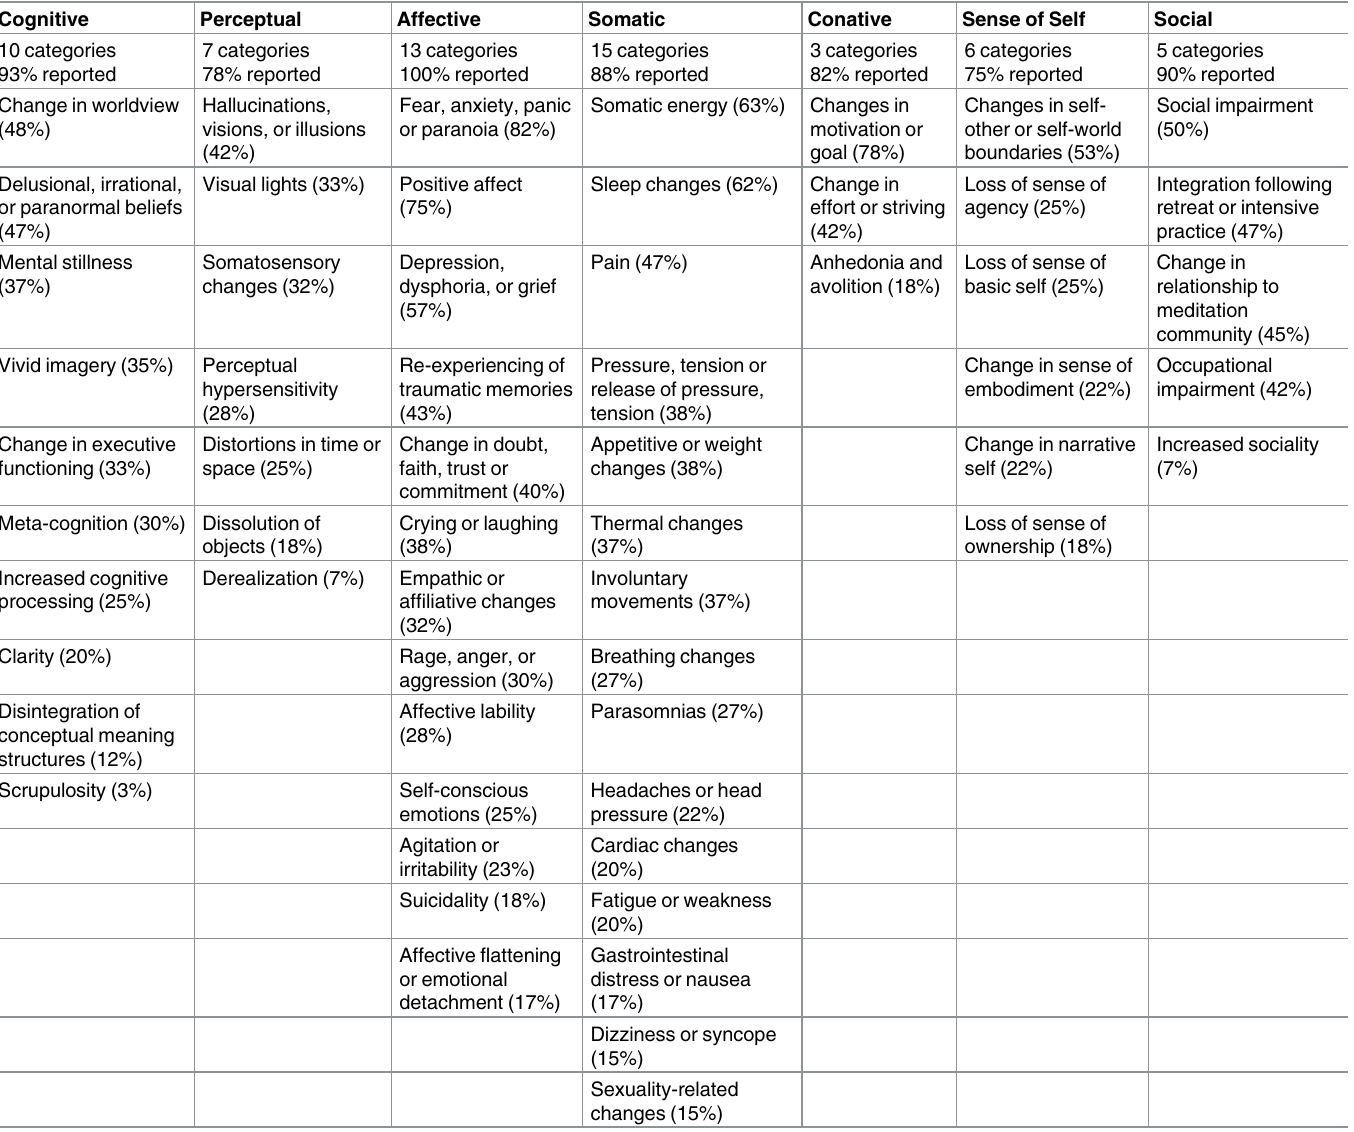
Table 4. Phenomenology coding